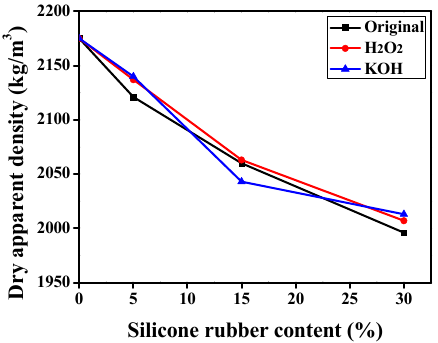
Figure 13. Dry apparent density of the original and modified silicone rubber mortar.